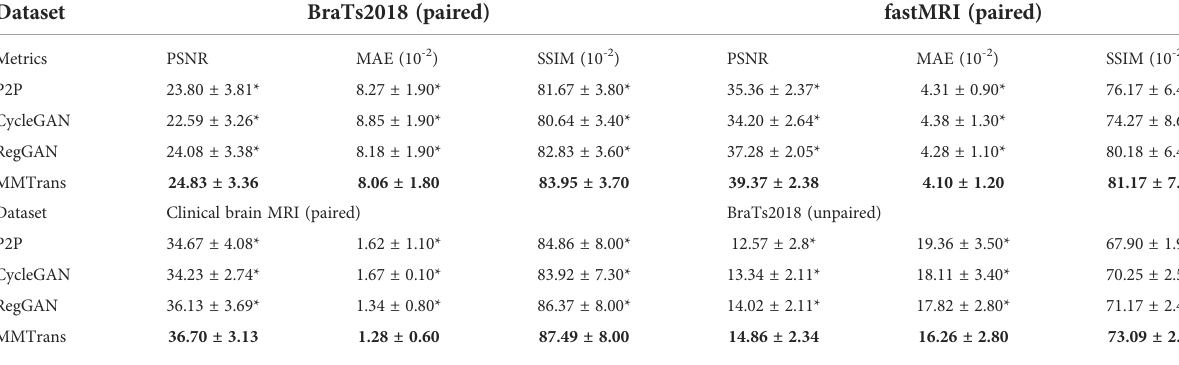
TABLE 3 Quantitative metrics results (mean and standard deviation) on different datasets in terms of PSNR, MAE, and